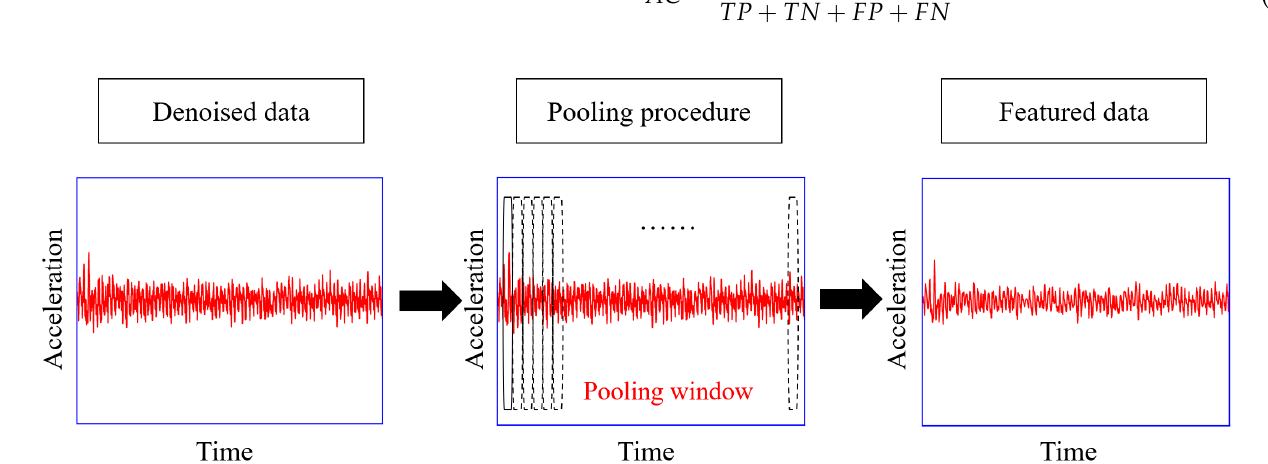
Figure 3. Pooling procedure.